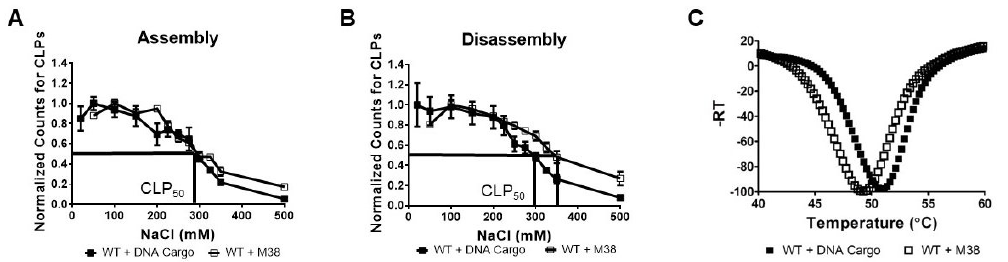
Figure 3. WT + M38 CLPs have similar stability to WT + DNA cargo CLPs. ( A , B ) DLS of CLP reactions under ( A ) assembly and ( B ) disassembly conditions. Each curve is an average of three biological replicates with the error bars representing the standard error of the mean (SEM). The method for determining the normalized counts for CLPs is described in the materials and methods. CLP 50 is the NaCl concentration at which 50% of the maximal CLPs were assembled / disassembled. ( C ) Thermal denaturation of WT + DNA Cargo and WT + M38 CLPs by DSF. Each curve is an average of three biological replicates. WT + DNA Cargo is represented as closed squares and WT + M38 as open squares.